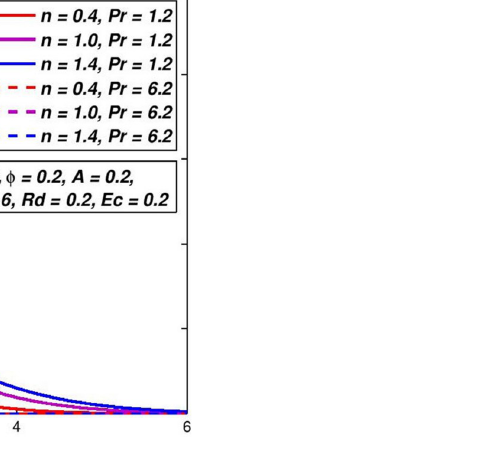
Fig 21. Effect of Pr on θ ( η ) for diverse n